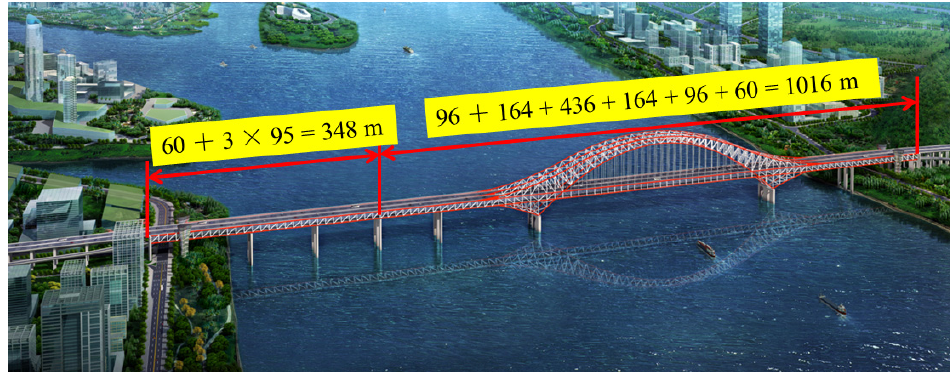
Figure 2. The general layout of the Guangzhou Mingzhu Bay bridge.